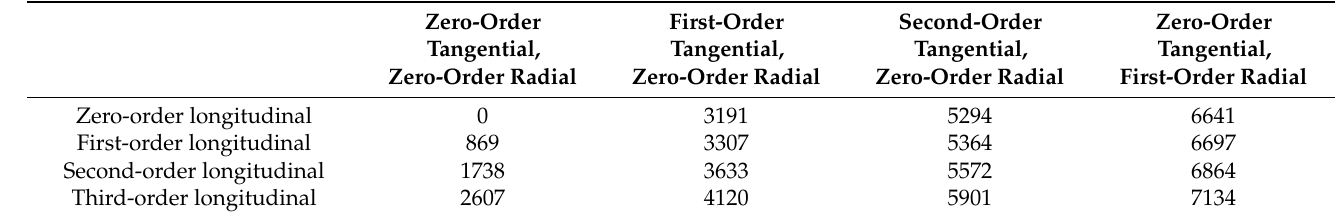
Table 5. Rough estimation of each modal frequency of the combustion chamber.